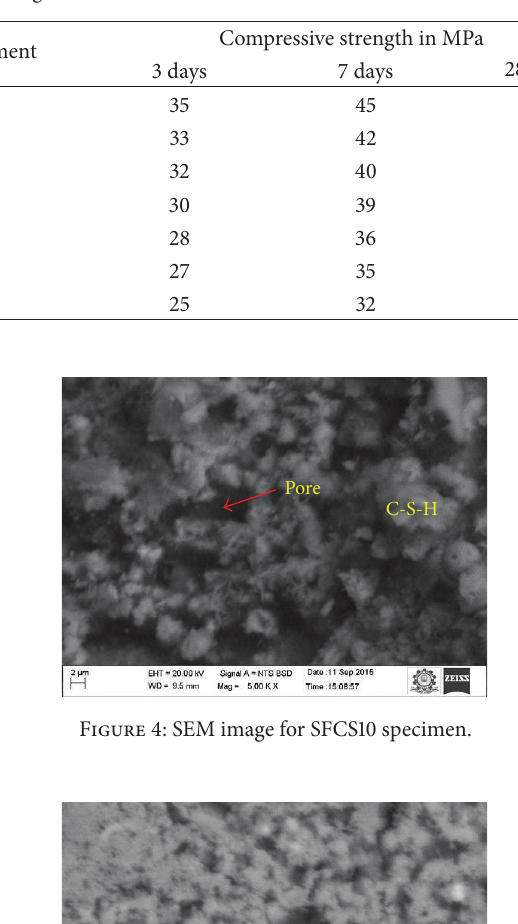
Table 2: Results on compressive strength of mortar cubes.